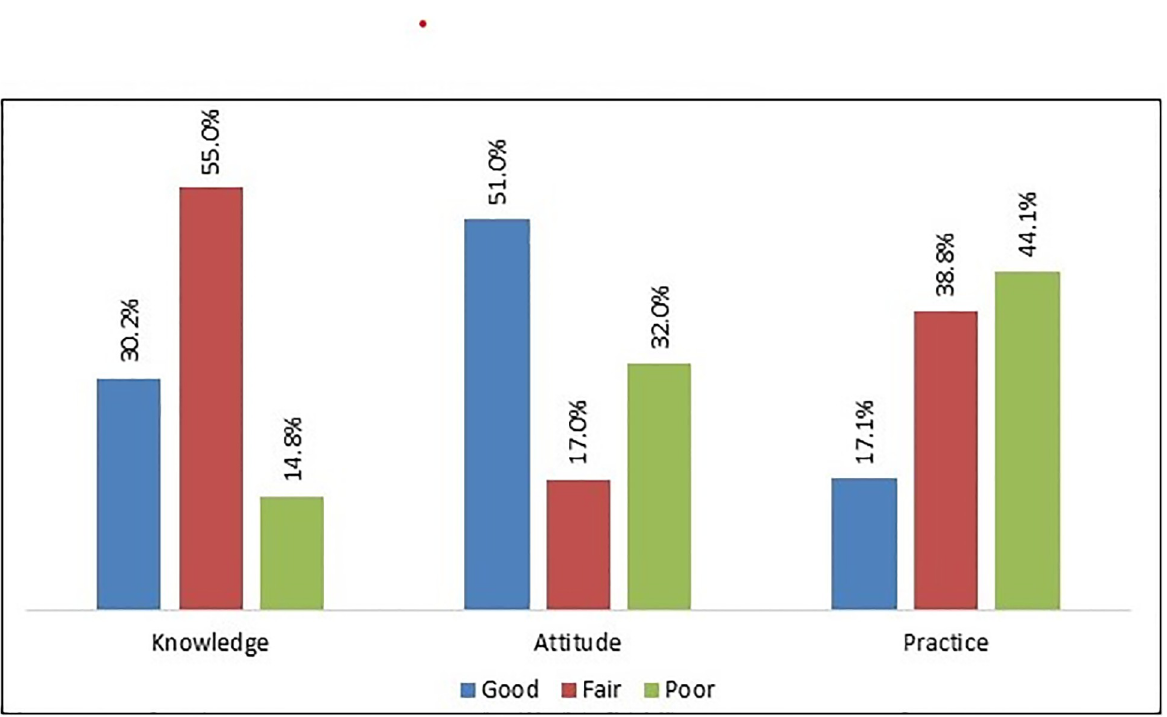
Fig 2. Percentage of different categories of KAP of nurses towards IPC.